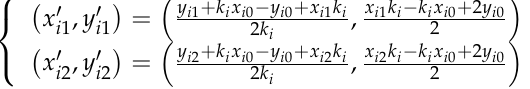
− 1, we can obtain new endpoints based on these parameters as follows: we can obtain new endpoints based on these parameters as follows: 